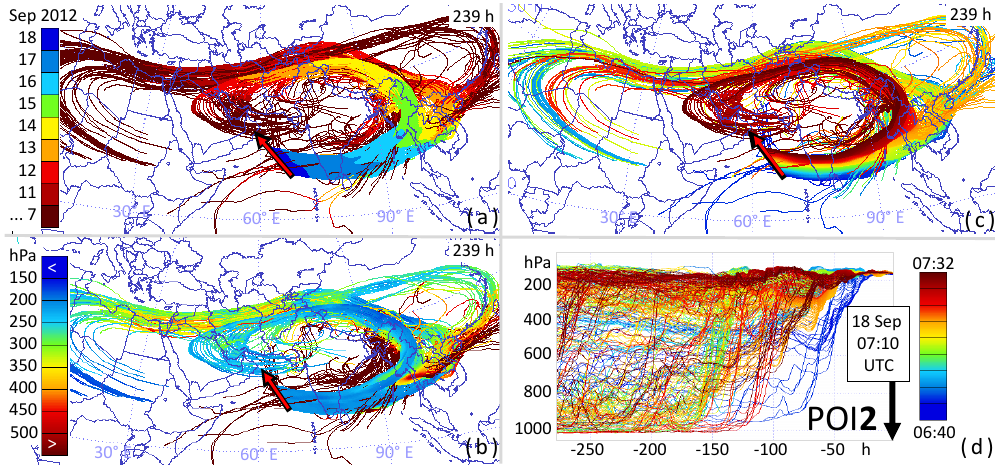
Figure A1. As Fig. 3, but for POI2. This flight segment covers the time after take-off and ascent until increased O 3 mixing ratios are encountered.